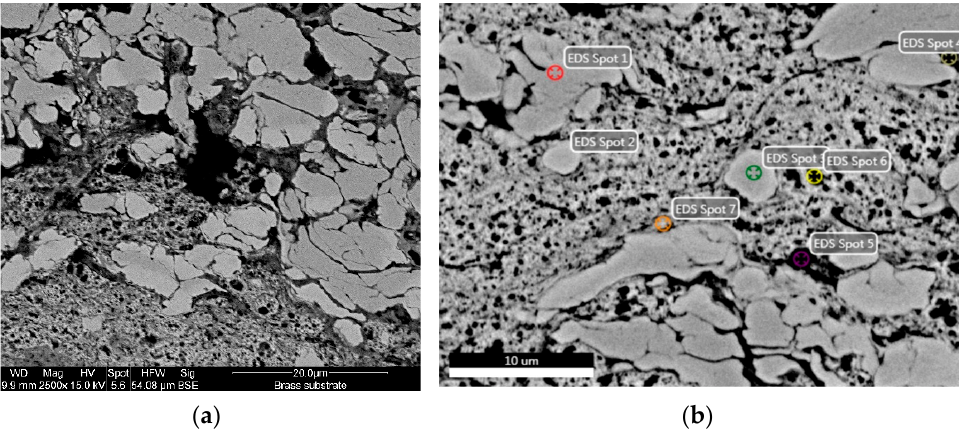
Figure 9. SEM micrograph of Cu-10%Zn-2%Graphene catalytic layer. ( a ) Sample topography, ( b ) the EDS analysis spots Table 3. EDX of Cu-10%Zn-2%Graphene catalytic layer.